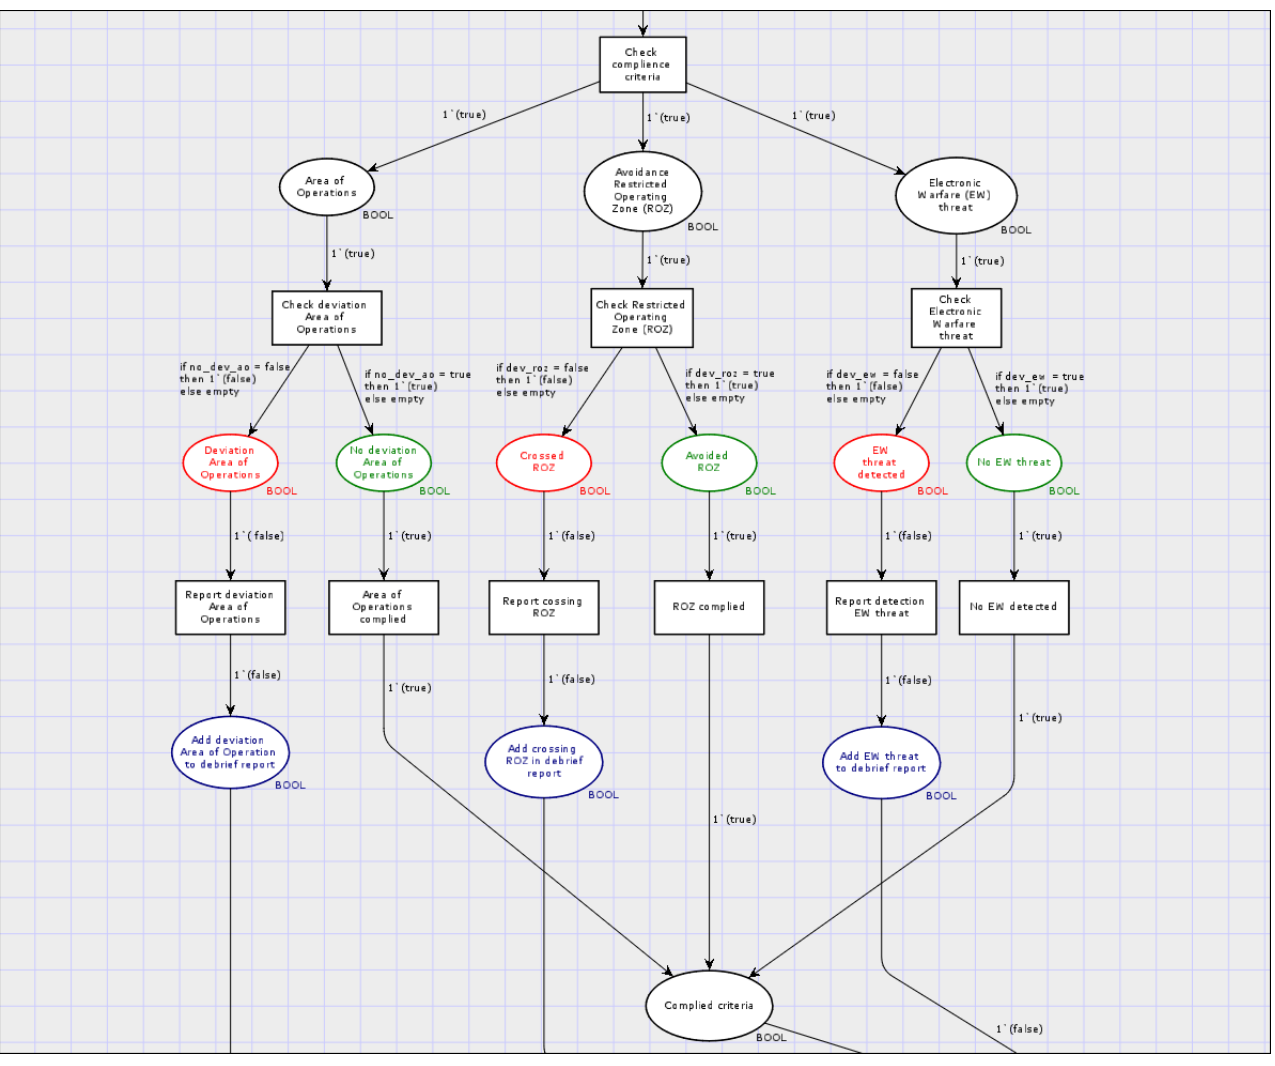
Figure 6. Criteria compliance check post-flight in evaluation